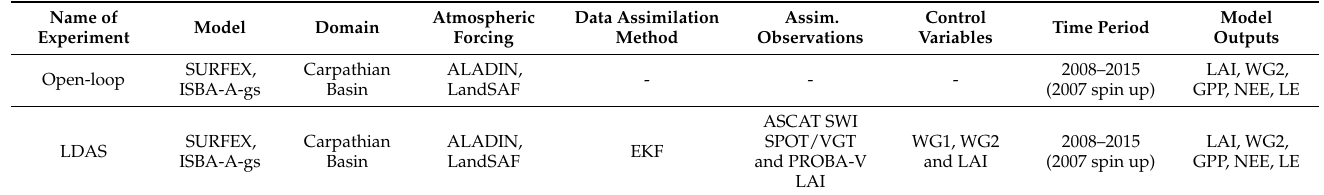
Table 1. Experimental setup of this